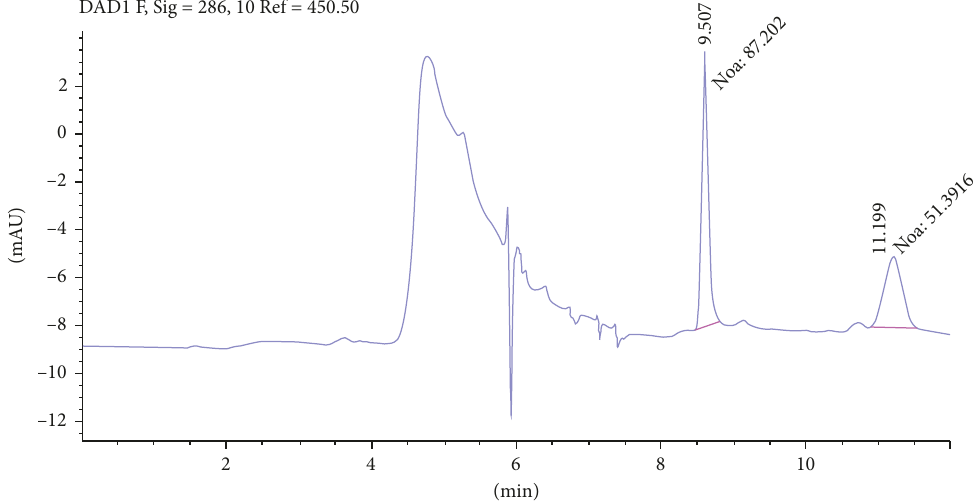
Figure 6: Fructose and sucrose peaks of the P2 sample, with fructose ( T